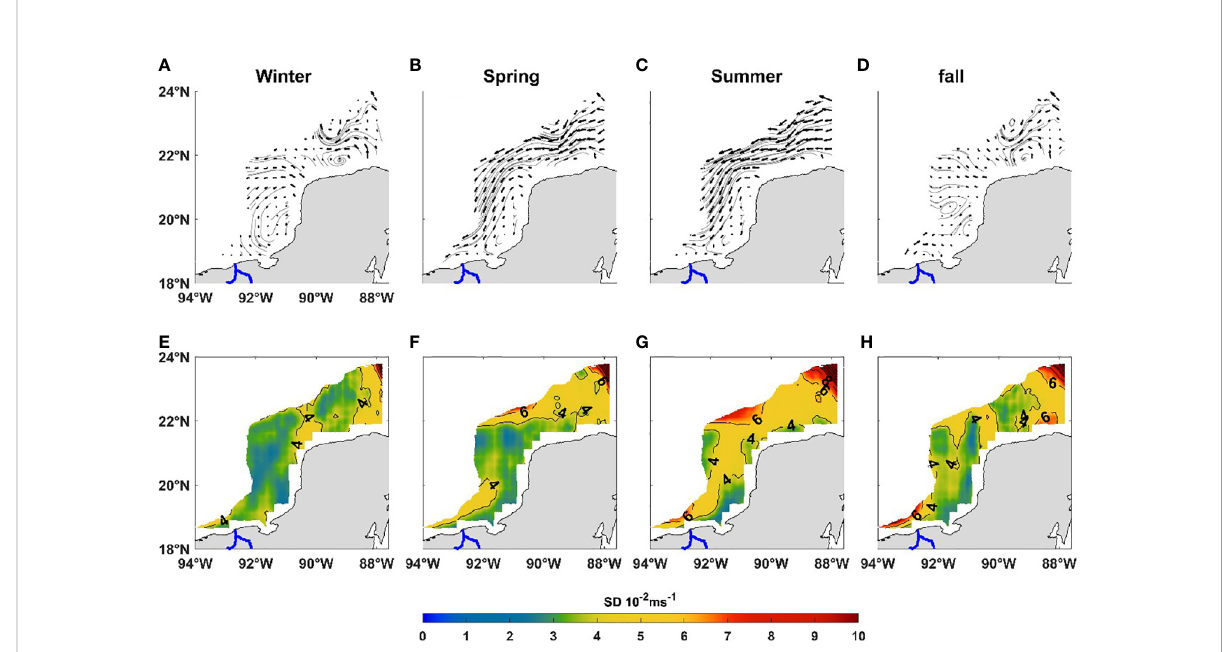
FIGURE 5 Seasonal climatology of the geostrophic velocity [ n g · 10 − 2 ms − 1 ] off the coast of Campeche and the zonal border of Yucata ́ n and its respective standard deviation. (A, E) winter, (B, F) spring, (C, G) summer, and (D, H) autumn. The blue outline corresponds to the GrijalvaUsumacinta river